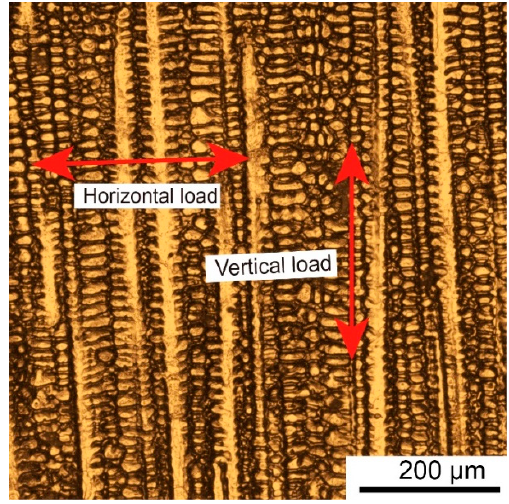
Figure 12. Schematic diagram of the metallographic structure and load-bearing mode.